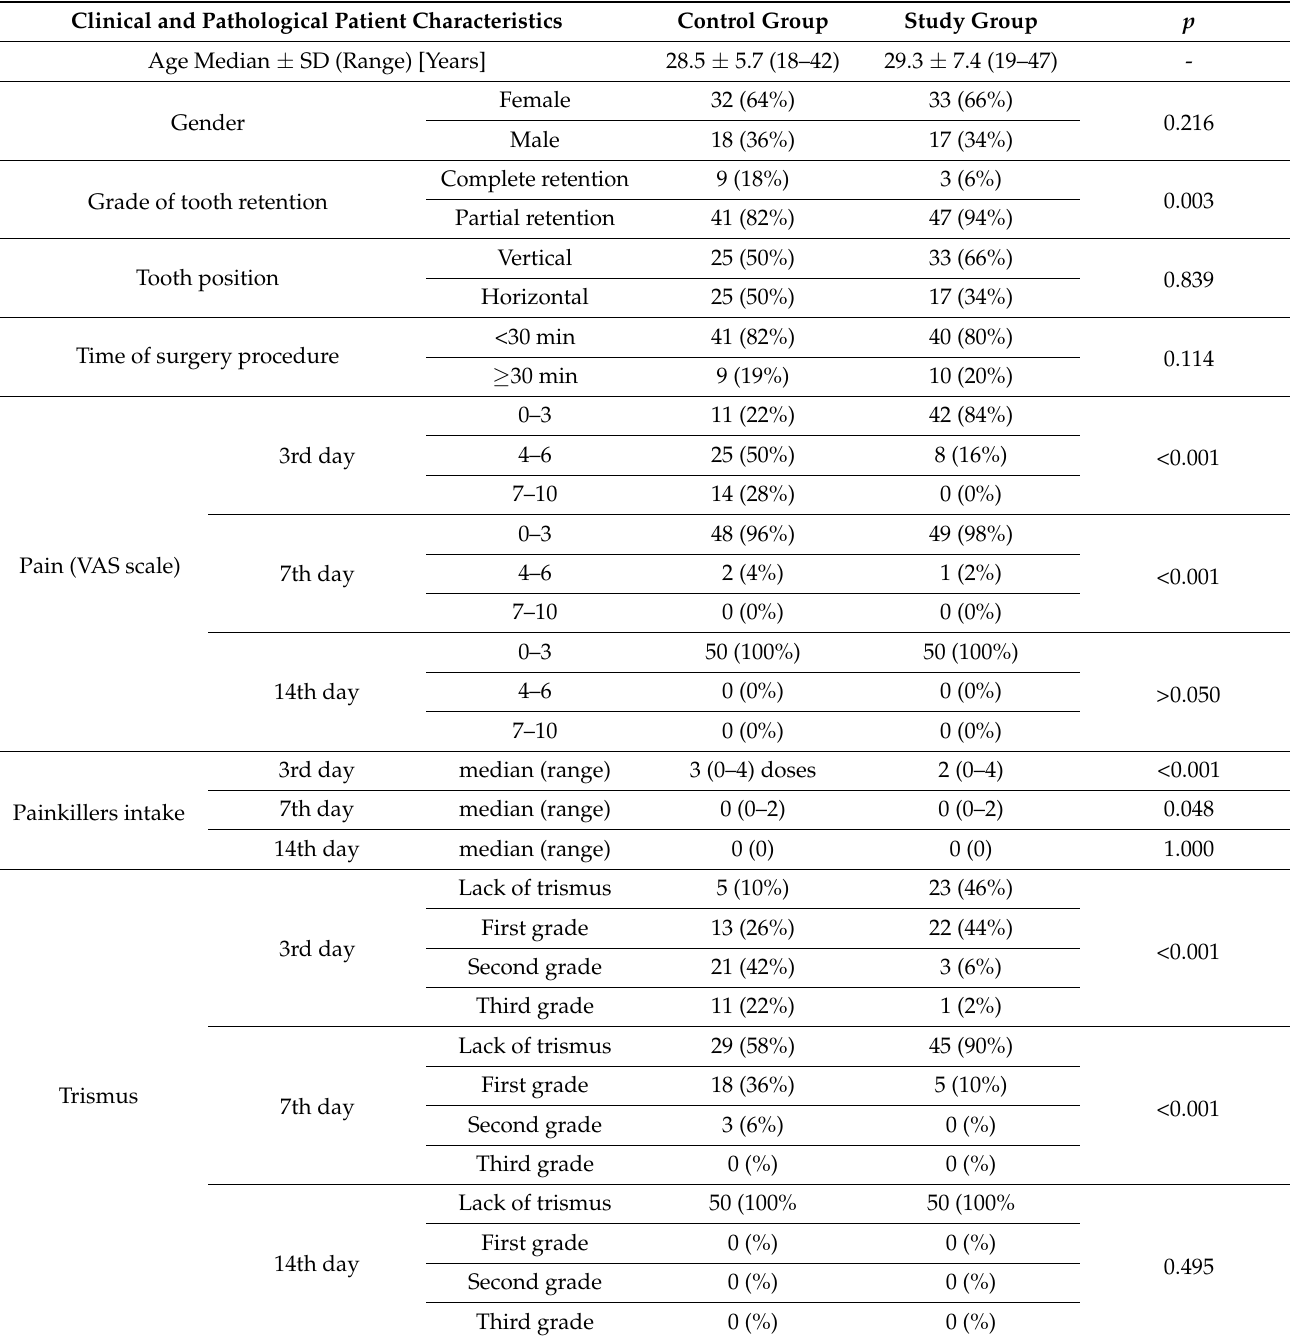
Table 1. Characteristic of patients and clinical features (SD—standard deviation; p — p